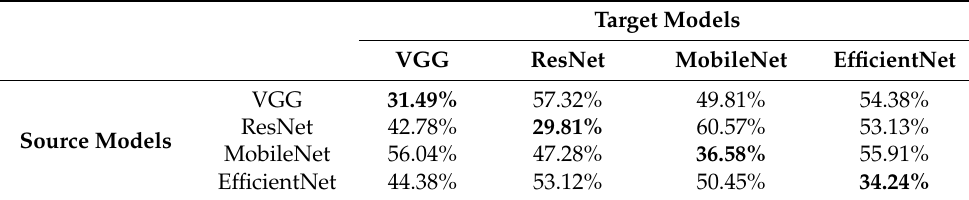
Table 7. Classification accuracy of each target classification model using the